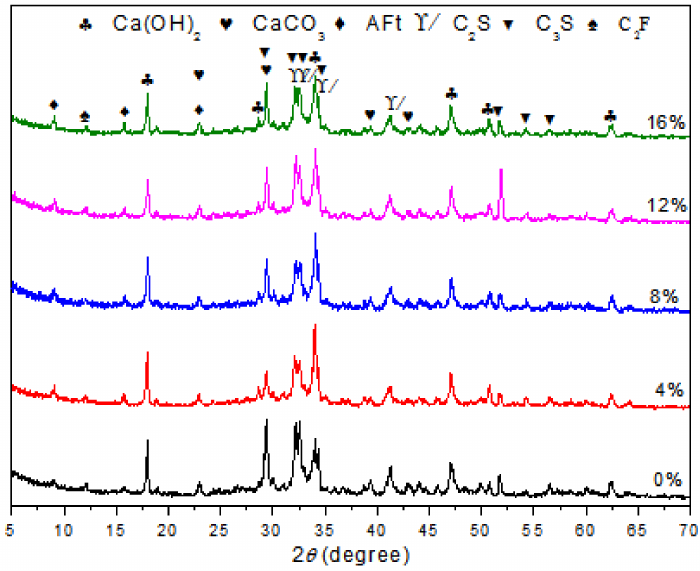
Figure 1. XRD patterns of cement paste and EVA-Modified cement pastes at 28 days of